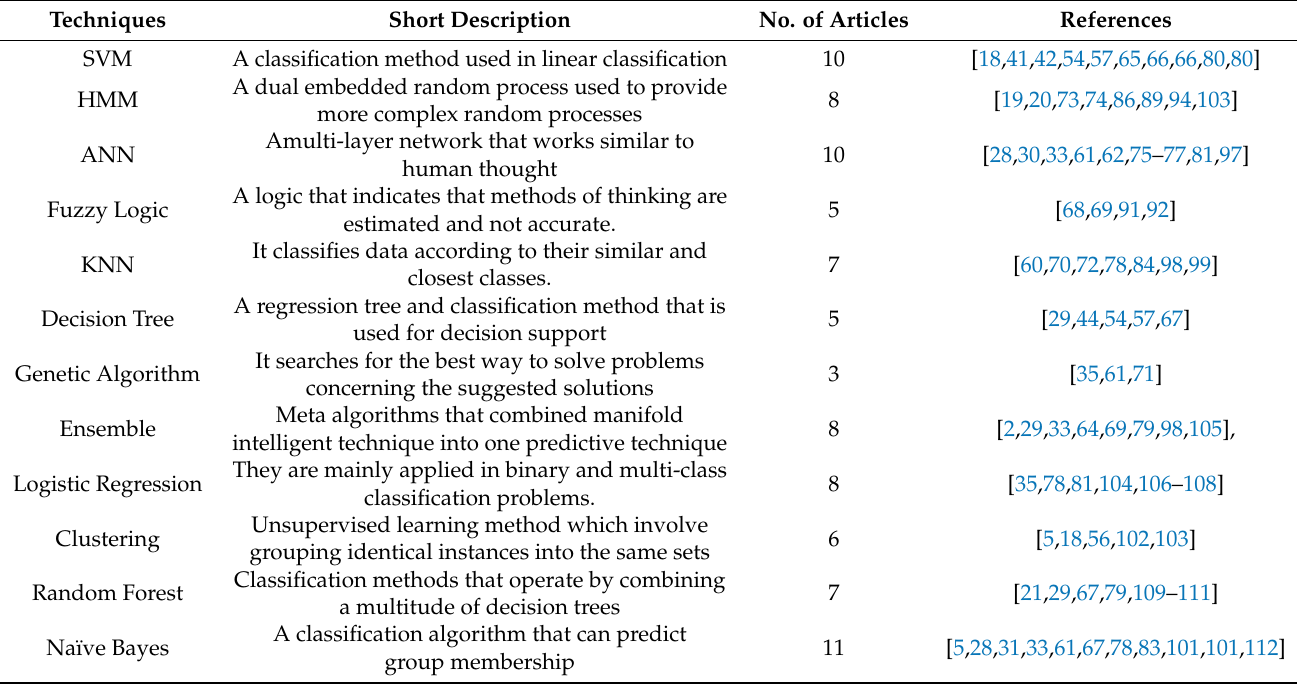
Table 6. ML techniques used for financial fraud